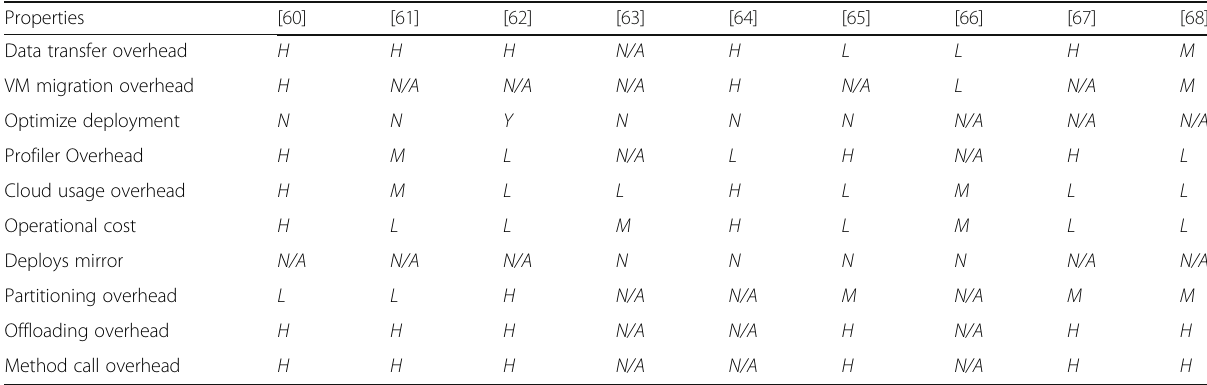
Table 3 Comparison of existing frameworks part-2 Properties